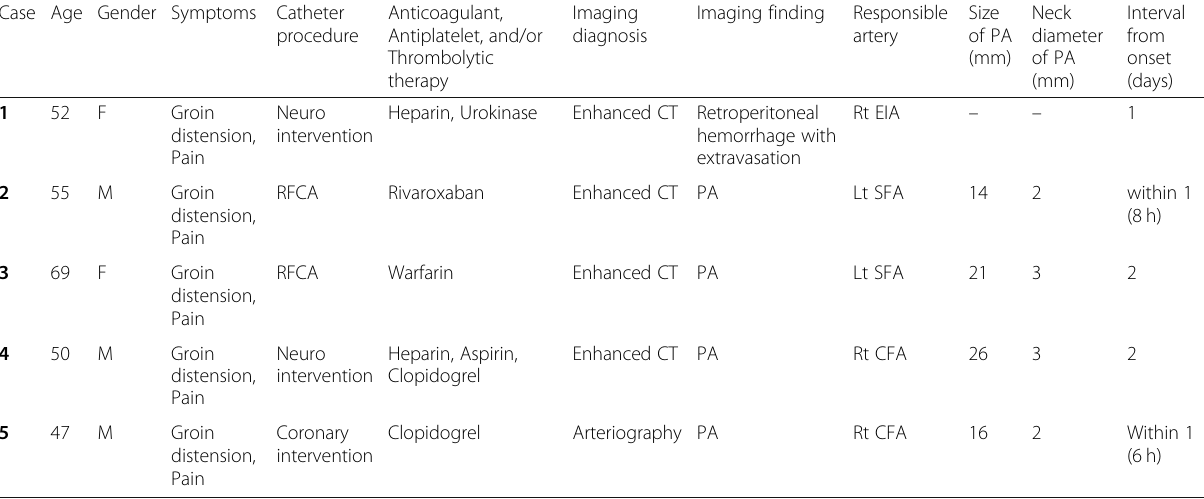
Table 1 Backgrounds of patients Case Age Gender Symptoms Catheter